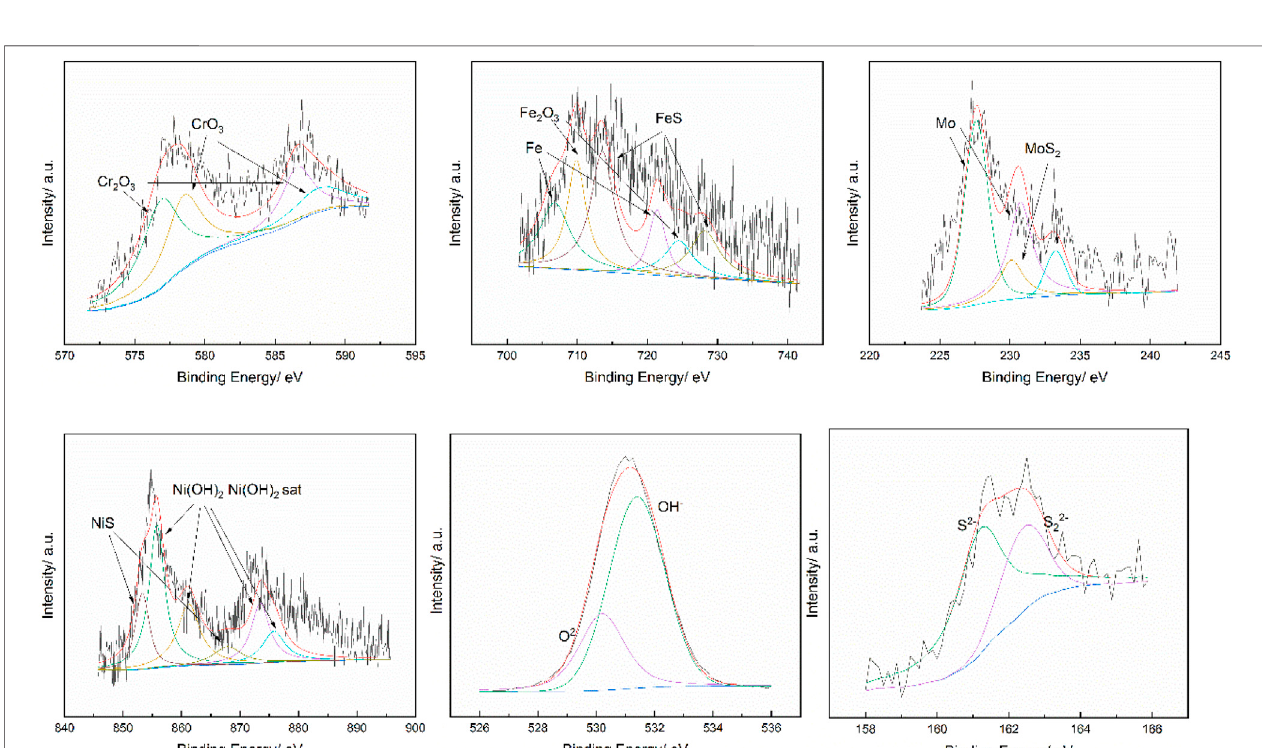
FIGURE 6 | XPS analysis results for Alloy 825 at 230 ° C, 1.2 MPa H 2 S 3.2 MPa CO 2 .